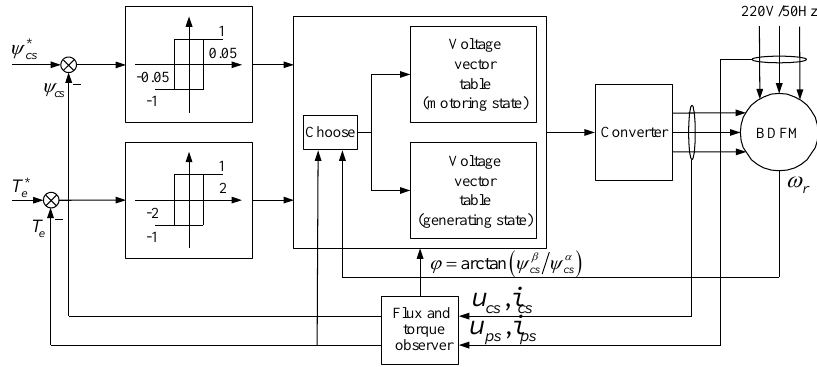
Figure 5. Control system of conventional DTC.